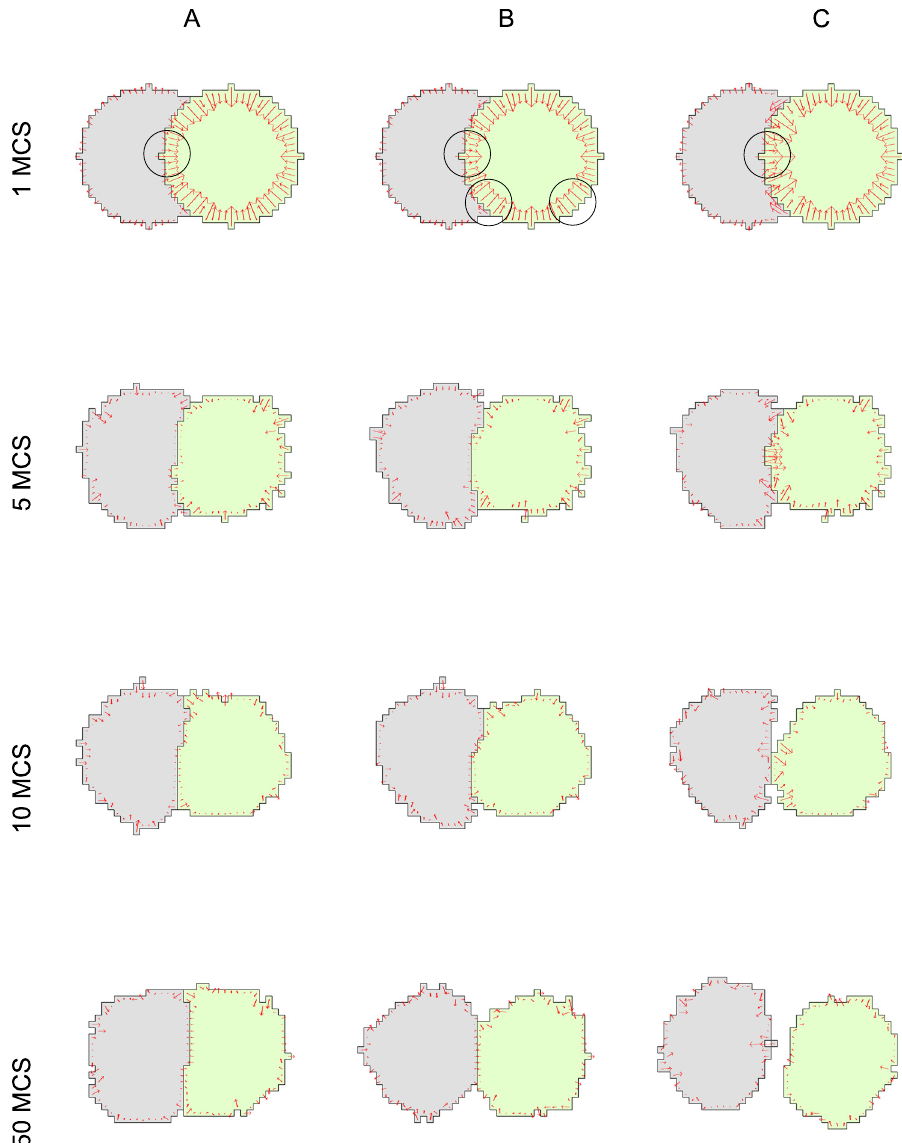
Fig 7. Forces due to cell-cell adhesion. Two CPM interacting cells in a time sequence from left to right. (A) cells adhere strongly J (1, 2) < 2 J (0, 1), (B) neutral adhesion of cells to medium and to one another J (1, 2) = 2 J (0, 1), (C) cells de-adhere, J (1, 2) > 2 J (0, 1); CPM parameters used were λ J (1, 2) = 1800 (for the adhesive), 3600 (for the neutral) or 7200 (for the repulsive) cases.